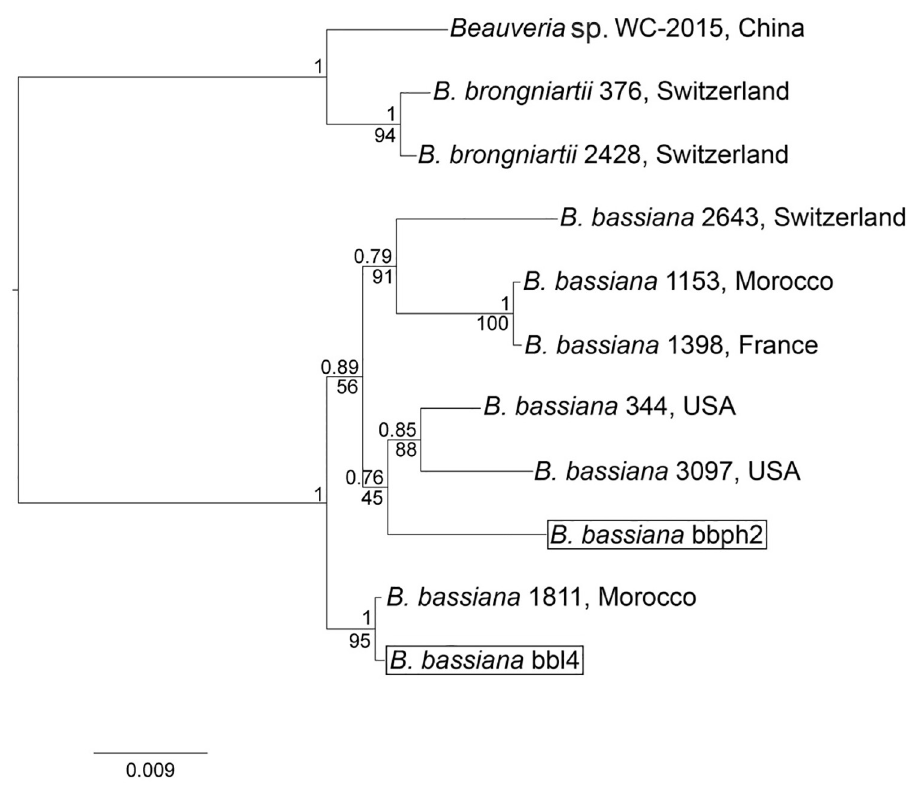
Fig 4. Bayesian consensus tree inferred on ITS, Bloc and EF1- α gene sequences. Support values expressed as Bayesian posterior probability are reported above the nodes, while below each nodes the approximate likelihood ratio test (as obtained in the Maximum Likelihood phylogenetic inference analysis performed on the same dataset) are recorded. Outgroups: Beauveria sp. and Beauveria brongniartii . The scale bar at the bottom indicates the distance expressed in substitutions per site. Isolates obtained in this study are surrounded by black